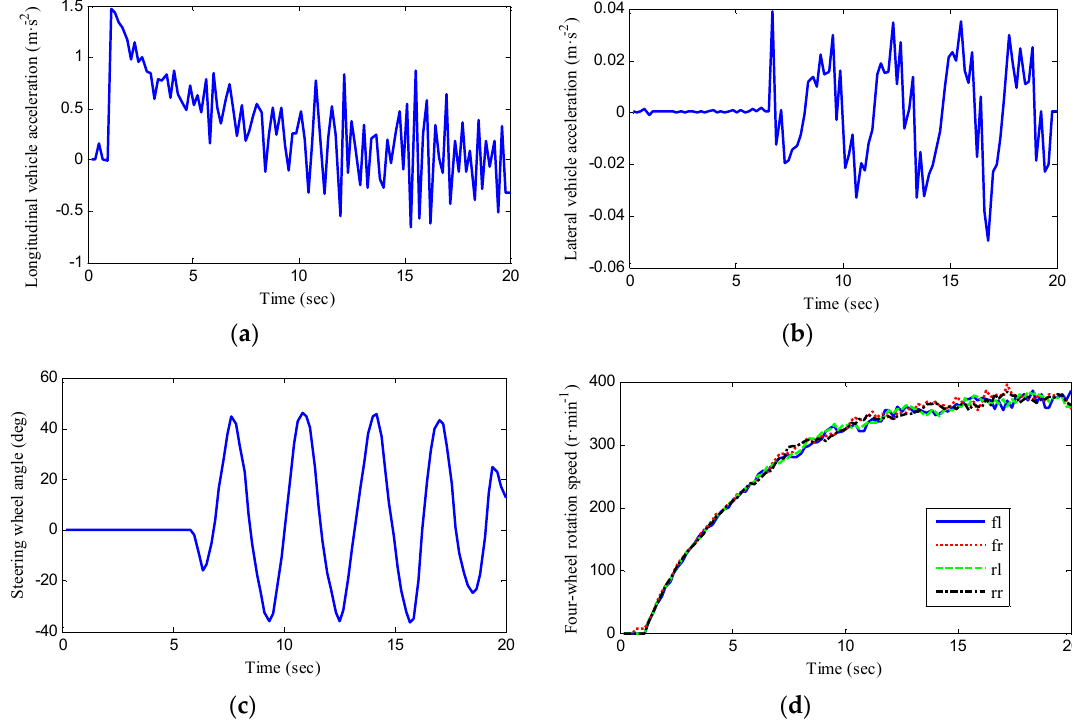
Figure 7. Measured running states of vehicle road test: ( a ) Longitudinal vehicle acceleration; ( b ) lateral vehicle acceleration; ( c ) steering wheel angle; ( d ) four-wheel rotation speed.